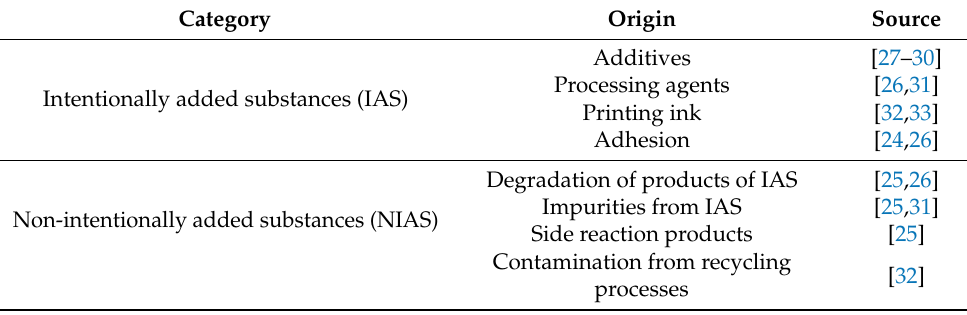
Table 1. A brief overview of intentionally and non-intentionally added substances in recycled plastic. Category Origin Source